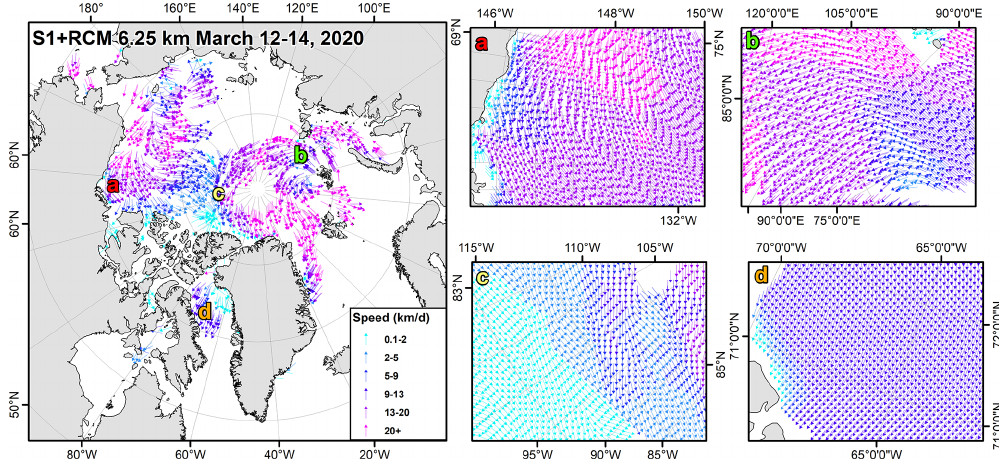
Figure 10. The spatial distribution of 6.25km 3d S1 + RCM sea ice motion on 12–14 March 2020. The letters correspond to zoomed-in regions on the map. Note that the white areas in the figure indicate either zero ice motion for the landfast ice or no ice motion information extracted (because of no SAR data, no ice, or no stable ice features).